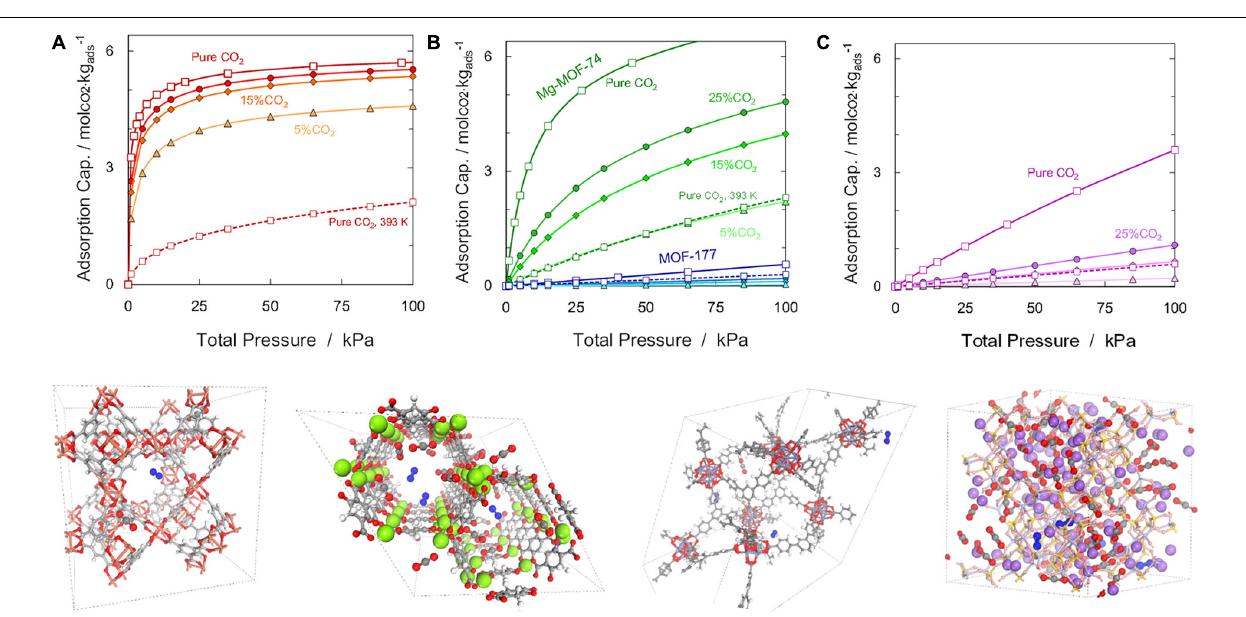
FIGURE 6 | Top: Comparison of simulated adsorption isotherms for pure carbon dioxide (squares) and the behavior under different mixture conditions: 25% CO 2 /75% N 2 binary mixture (circles), 15% CO 2 /85% N 2 binary mixture (diamonds), and 5% CO 2 /95% N 2 binary mixture (triangles) for (A) NaX, (B) Mg-MOF-74 and MOF-177, and (C) CuBTC at 313 K. Dashed lines for pure CO 2 at 393 K. Bottom: Snapshot of competition sites on selected crystallographic structures at 100 kPa and 313 K for 5% CO 2 /95% N 2 binary mixture: color key—O, red; C, gray; Mg, green; H, white; Cu, orange; Zn, purple; N, blue; Si, yellow; Al, pink; and Na,